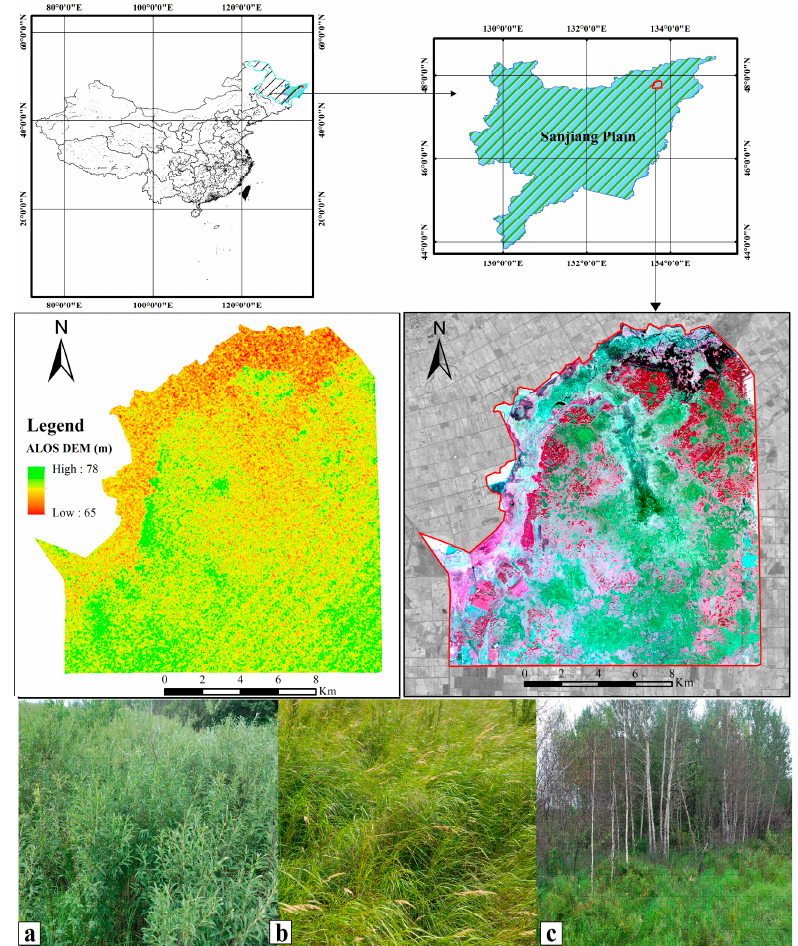
Figure 1. Study area (Gaofen-1 (GF-1) false-color image display: bands 4, 3, 2 in red, green, blue (RGB)) and vegetation associations. ( a ) Salix brachypoda ; ( b ) shallow-water plants; ( c ) Betula platyphylla forest. Table 1. Classification types for mapping marsh vegetation in Honghe National Nature Reserve (HNNR).